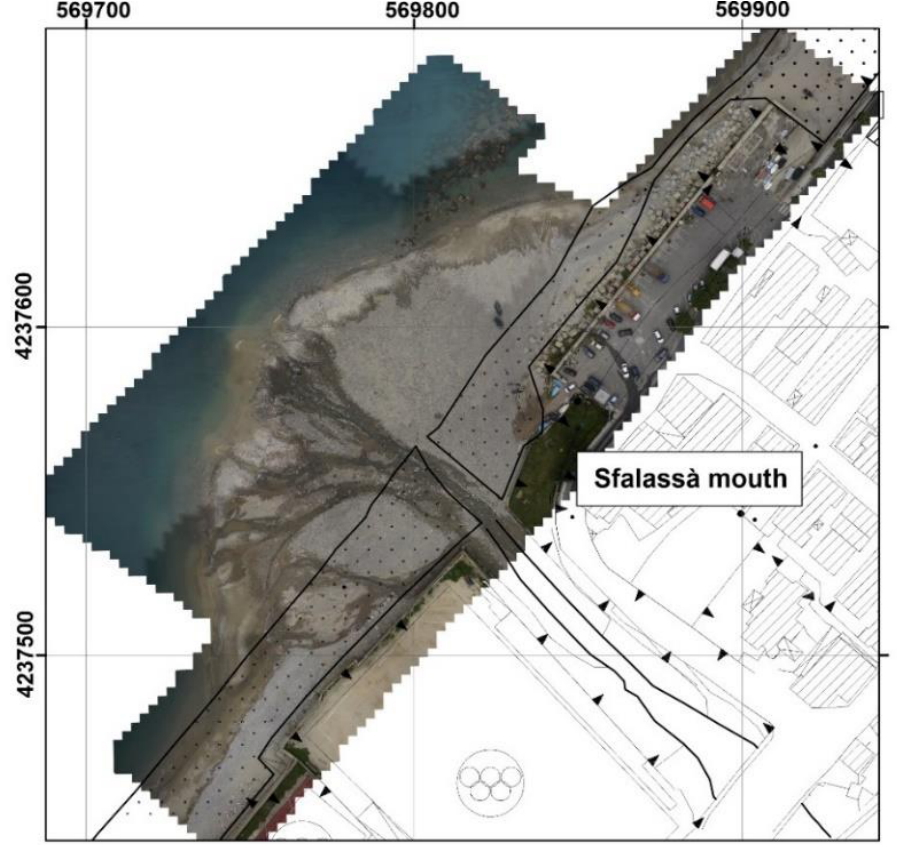
Figure 7. The fan delta’s drone image draped over the Calabria Region’s technical map at 1:5000 scale. Source: own elaboration.